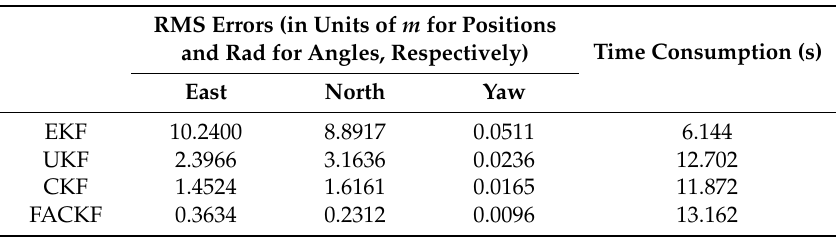
Table 4. Summary of RMS errors and the time consumption for Scenario 1.